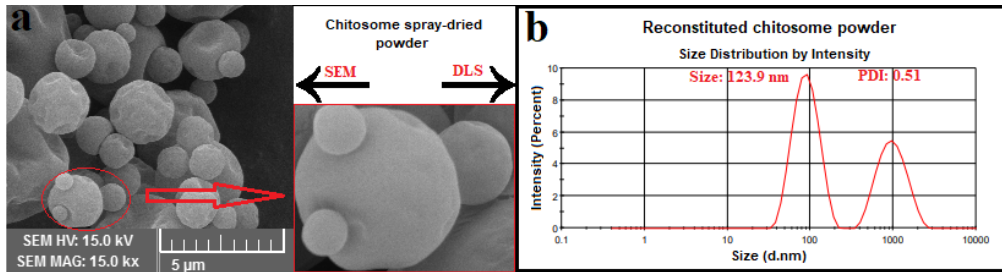
Figure 4. ( a ) SEM image of spray-dried hydrolysate-loaded γ -oryzanol-chitosomes; ( b ) particle size result of reconstituted γ -oryzanol-chitosome powder.